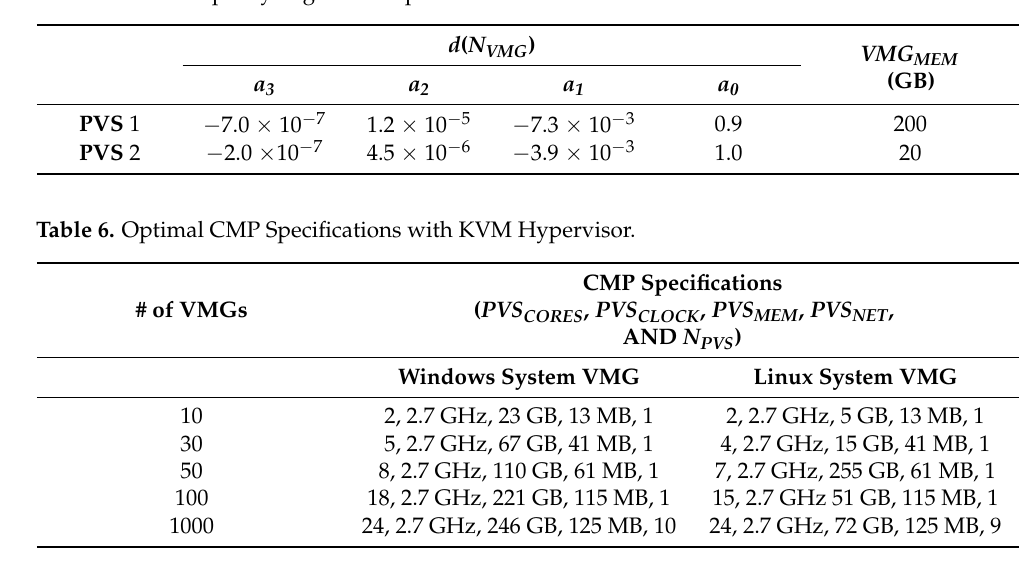
Figure 9. Comparison of measured and estimated utilization: ( a ) Utilization of PVS 1 (left: measured, right: estimated); ( b ) Utilization of PVS 2 (left: measured, right: estimated). Table 5. Server capacity degradation parameters of CPU and MEM.